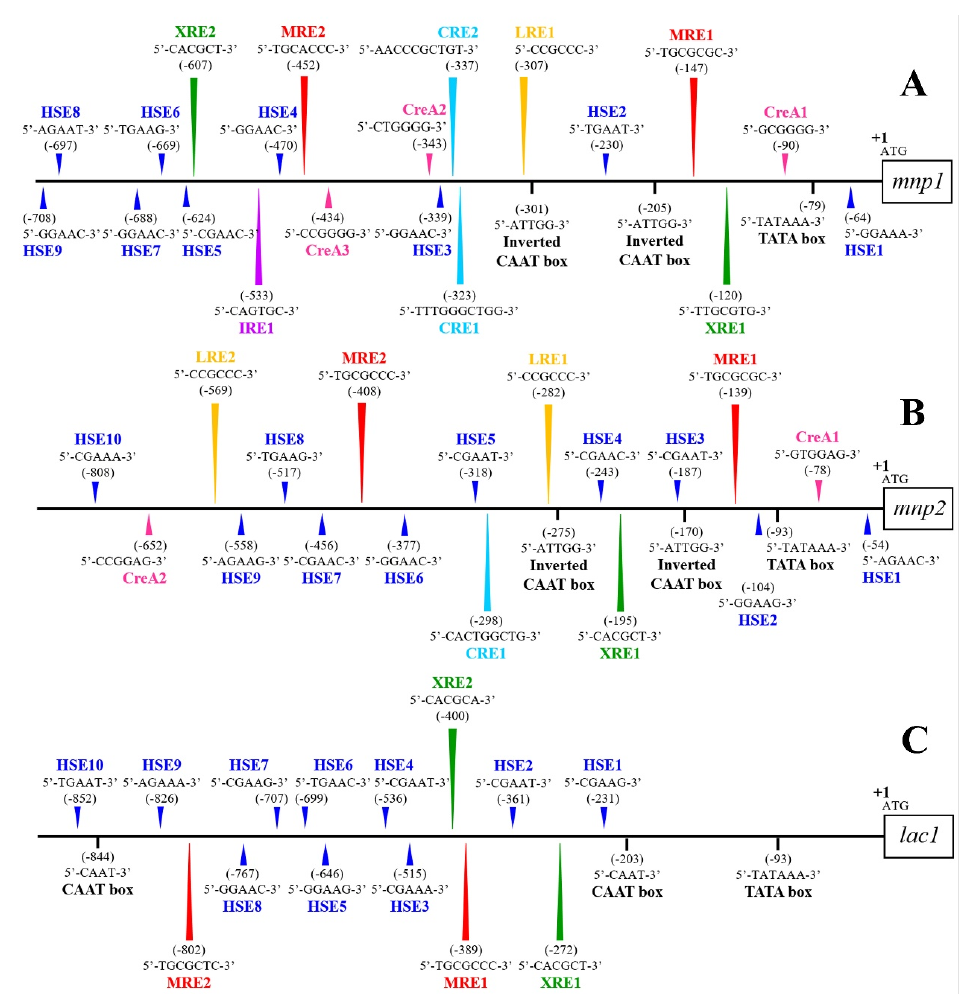
Figure 3. The scheme of the cis -acting element of ( A ) mnp1 , ( B ) mnp2 , and ( C ) lac1 upstream promoter from ATG. LRE, light responsive element; MRE, metal ion responsive element; XRE, xenobiotic responsive element; CRE, copper responsive element; IRE, iron responsive element; CreA, CreA binding site or cAMP responsive element; and HSE, heat shock element. The first nucleotide of start codon (ATG) is labeled as +